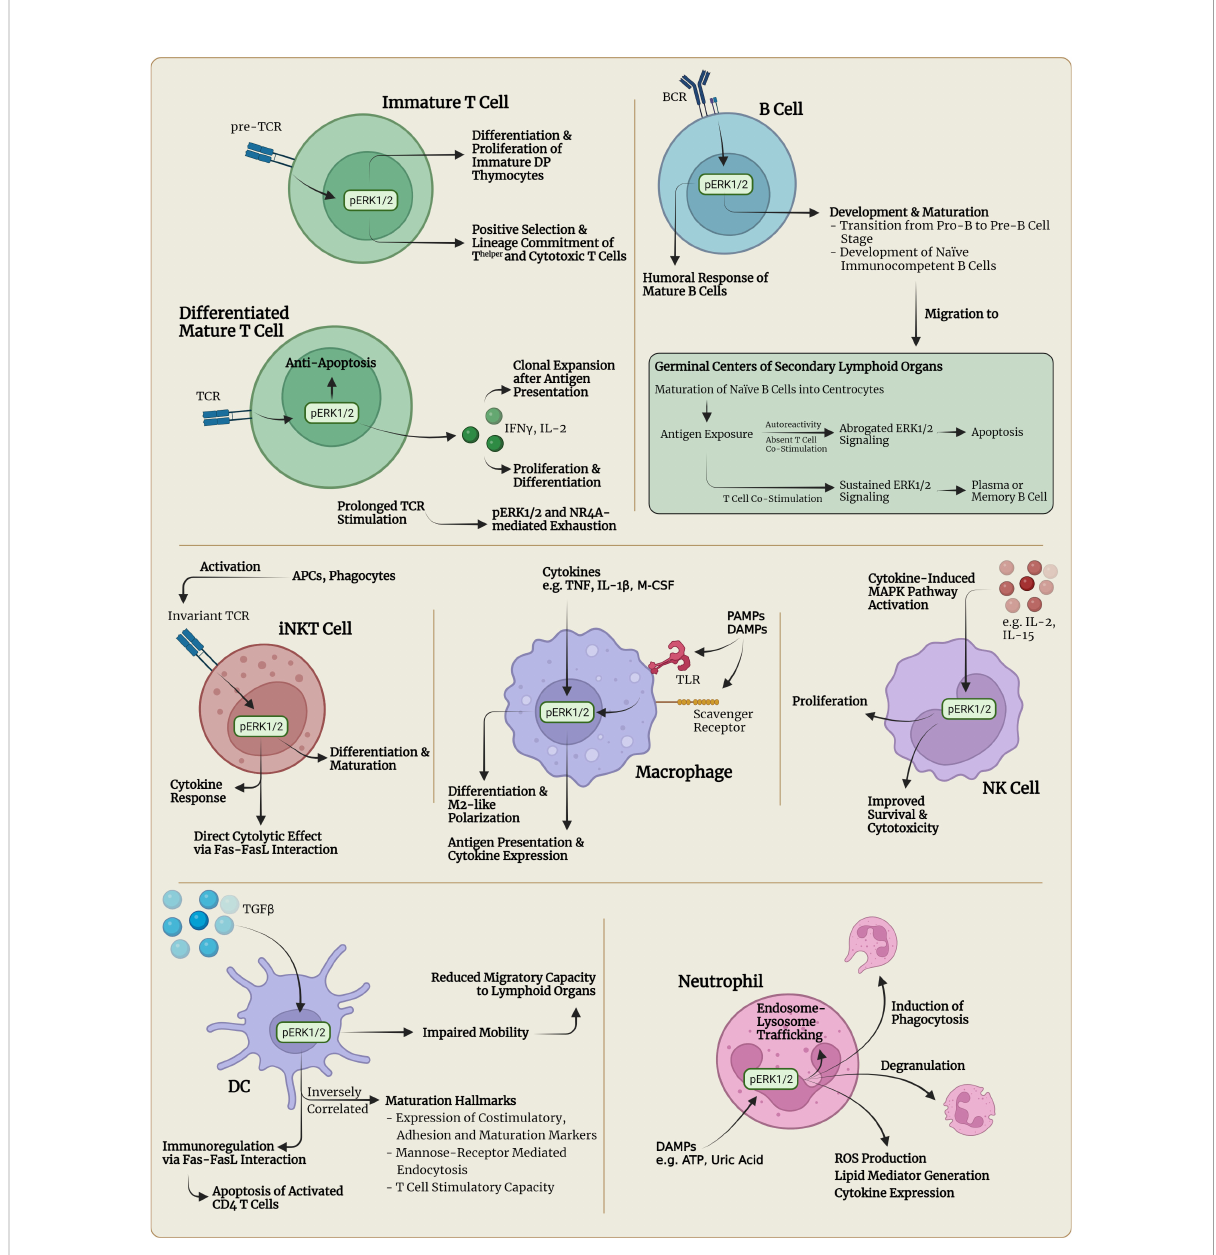
FIGURE 1 Visualization of selected immunophysiological consequences of pERK1/2 signaling in different immune cell types. APC, antigen-presenting cell; ATP, adenosine triphosphate; BCR, B cell receptor, DAMPs, damage-associated molecular patterns; DC, dendritic cell; DP thymocytes, double positive (CD4 + CD8 + ) thymocytes; IL, interleukin; IFN, interferon; M-CSF, macrophage colony-stimulating factor; NK, natural killer; NKT, natural killer T; PAMPs, pathogen-associated molecular patterns; ROS, reactive oxygen species; TCR, T cell receptor; TLR, Toll-like receptor; TNF, tumor-necrosis